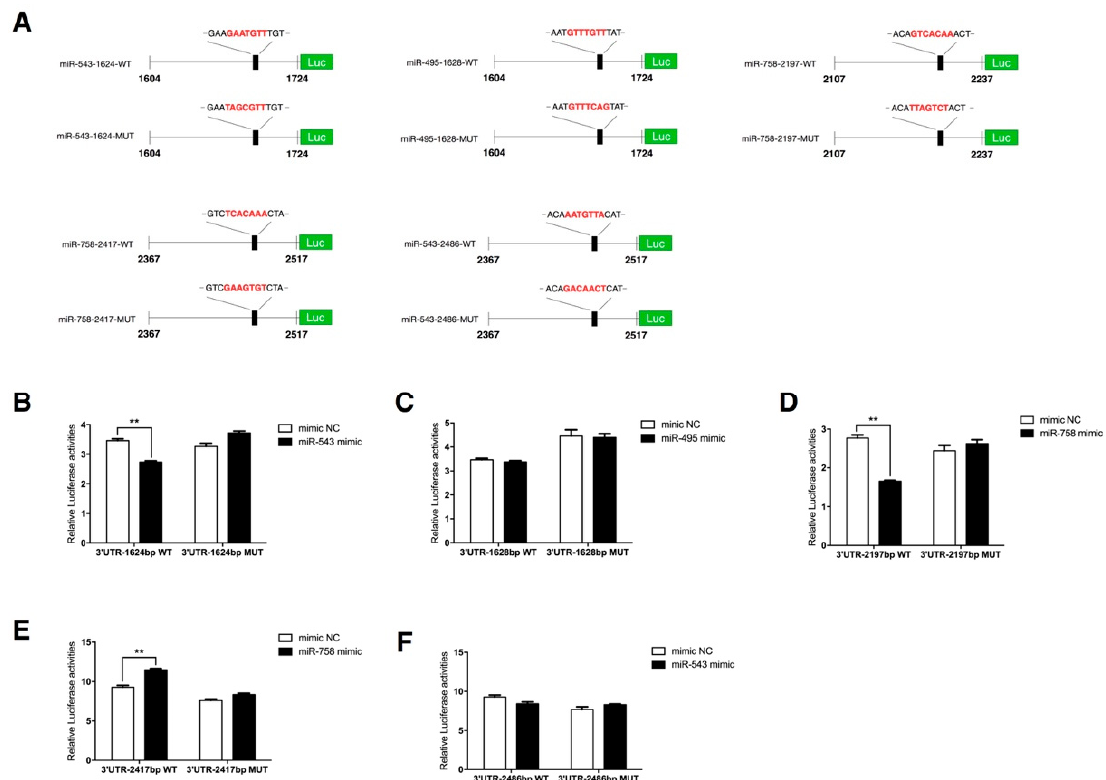
Figure 6. PPP2R2C is a direct target of miR-758 and miR-543. ( A ) Construction of the luciferase reporter vectors for 3 ′ UTR of PPP2R2C mRNA containing wild type (WT) or mutant (MUT) miRNA binding sites. The seed sequences of the WT and MUT miRNA binding sites are marked in red; ( B – F ) Luciferase reporter activity assay of PPP2R2C mRNA 3 ′ UTR containing the five potential miRNA binding sites. Error bars represent SEM. “**” represents p < 0.01.